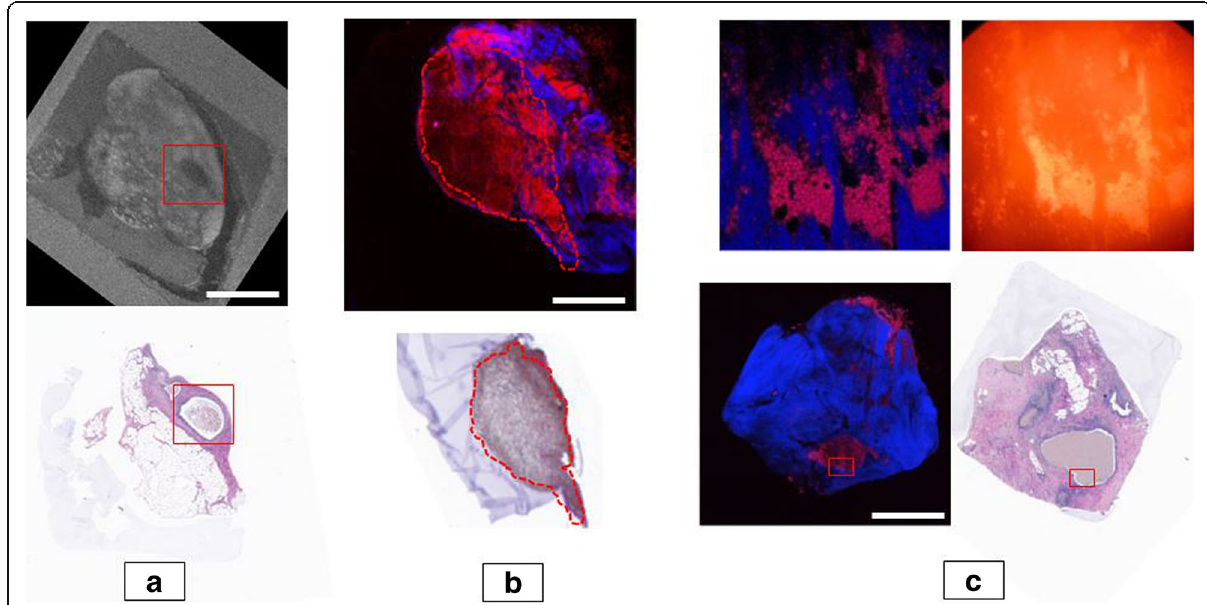
Fig. 1 Imaging Results. 1 a Sample 29-1a, the top image is the OCT en face image, the bottom image is the histology, the identified gland is boxed in red, scale bar is 1 mm 1 b Sample 20 – 6, TPM image on top, histology on bottom, hemosiderin is circled in red and appears as brown in the histology due to H&E stain, the TPM image is colored based on emission channel, the red represents 690 nm (hemosideran), blue is 500 nm (collagen), scale bar is 1 mm 1 c : Sample 34 – 1 The image on the top left is the single photon microscopy/ wide field fluorescence, very bright spots match with TPM and histology as hemosiderin, the image on the top right is the corresponding TPM image location colored as stated in 1b these are scale to 470 um × 470 um, the bottom right is the full TPM image and bottom left is the corresponding histology, the red box represents the area of the top images, scale bar is 1 mm